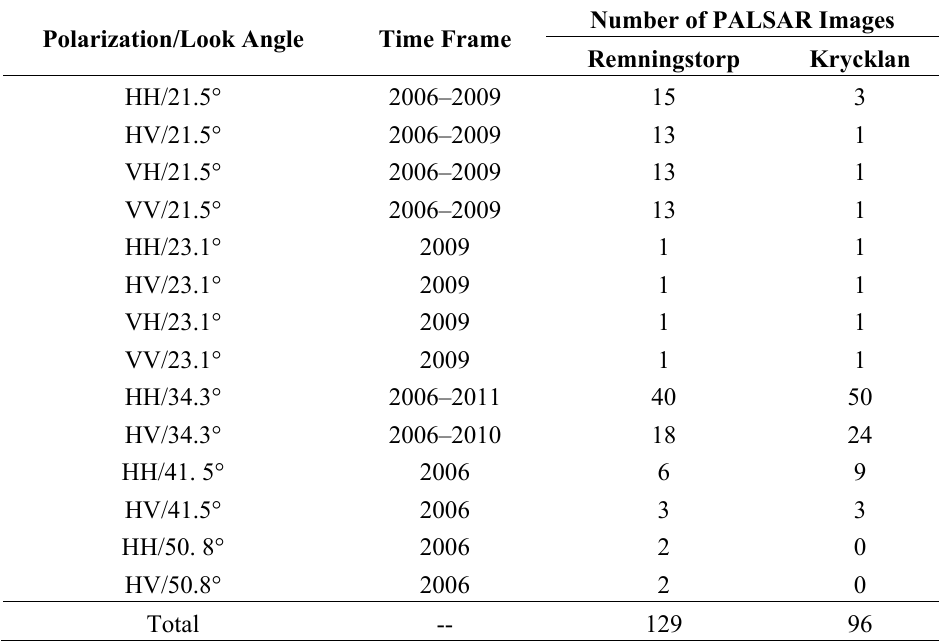
Table 3. Number of PALSAR images available over Remningstorp and Krycklan grouped according to polarization and look